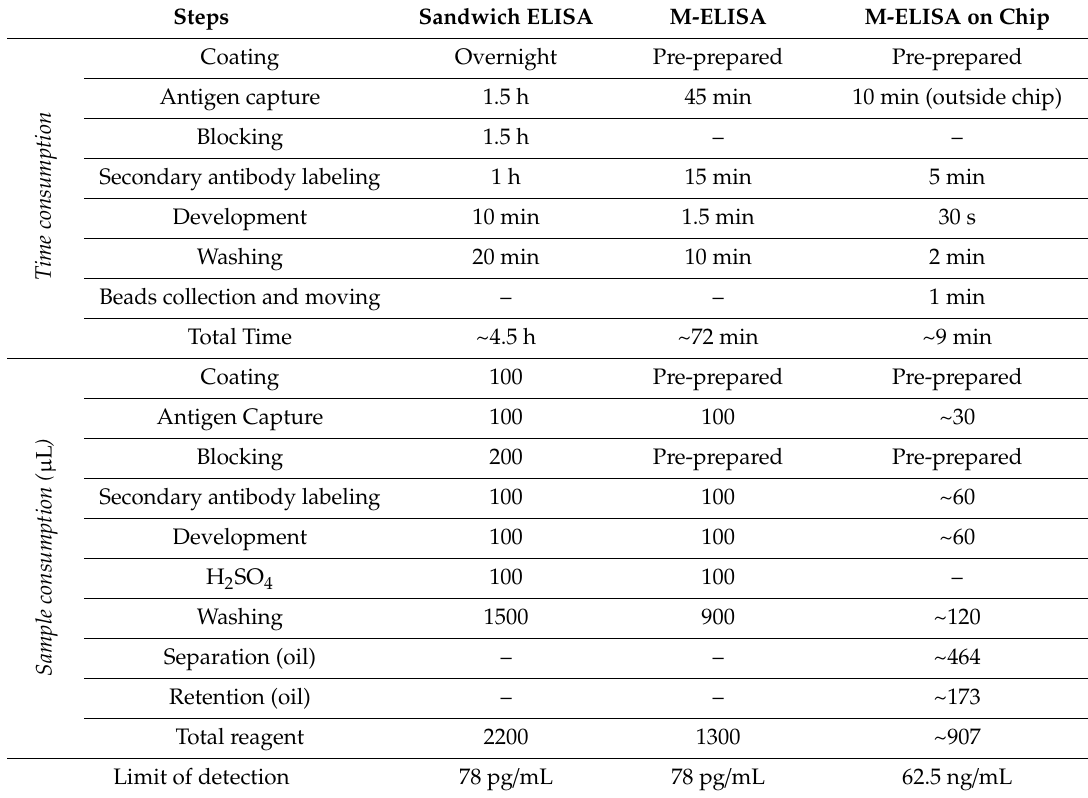
Table 1. Time comparison of sandwich ELISA, M-ELISA, and M-ELISA on